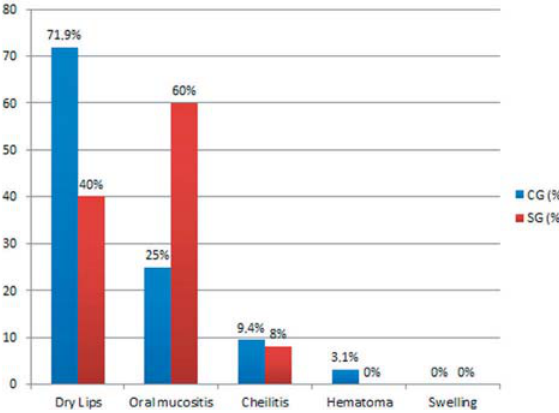
Figure 2- Stomatologic alterations in 57 patients undergoing chemotherapy. SG, Study Group; CG, Control